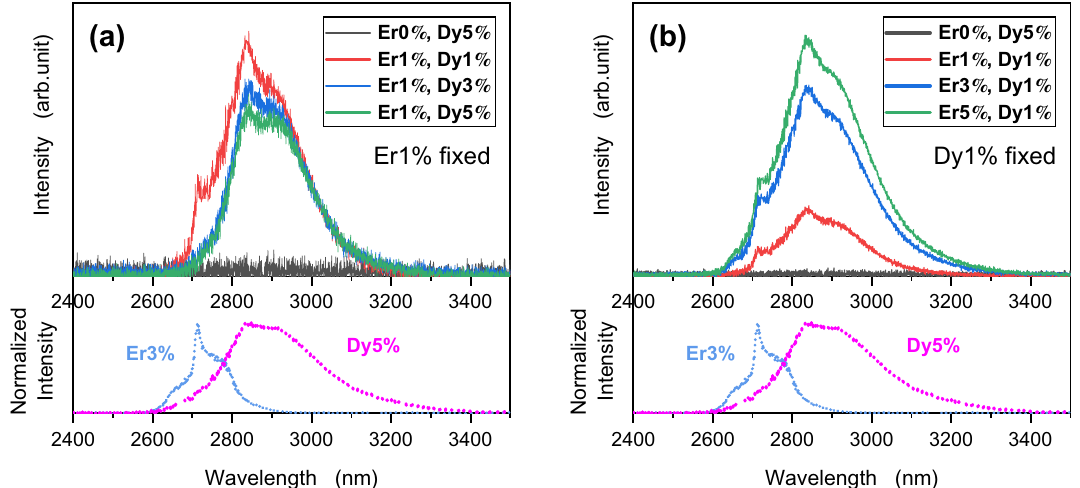
Figure 1. Fluorescence spectrum showing the normalized intensity as a function of wavelength, as obtained from the co-doped bulk media. The emission spectra of Er 3+ :ZBLAN (976-nm pump) in blue and Dy 3+ :ZBLAN (1700-nm pump) in pink are displayed in the lower plots. ( a ) Er 3+ concentration fixed at 1 mol%. ( b ) Dy 3+ concentration fixed at 1 mol%. In the legend, a concentration of, for example, 0 mol% Er 3+ and 5 mol% Dy 3+ is represented as “Er0%,